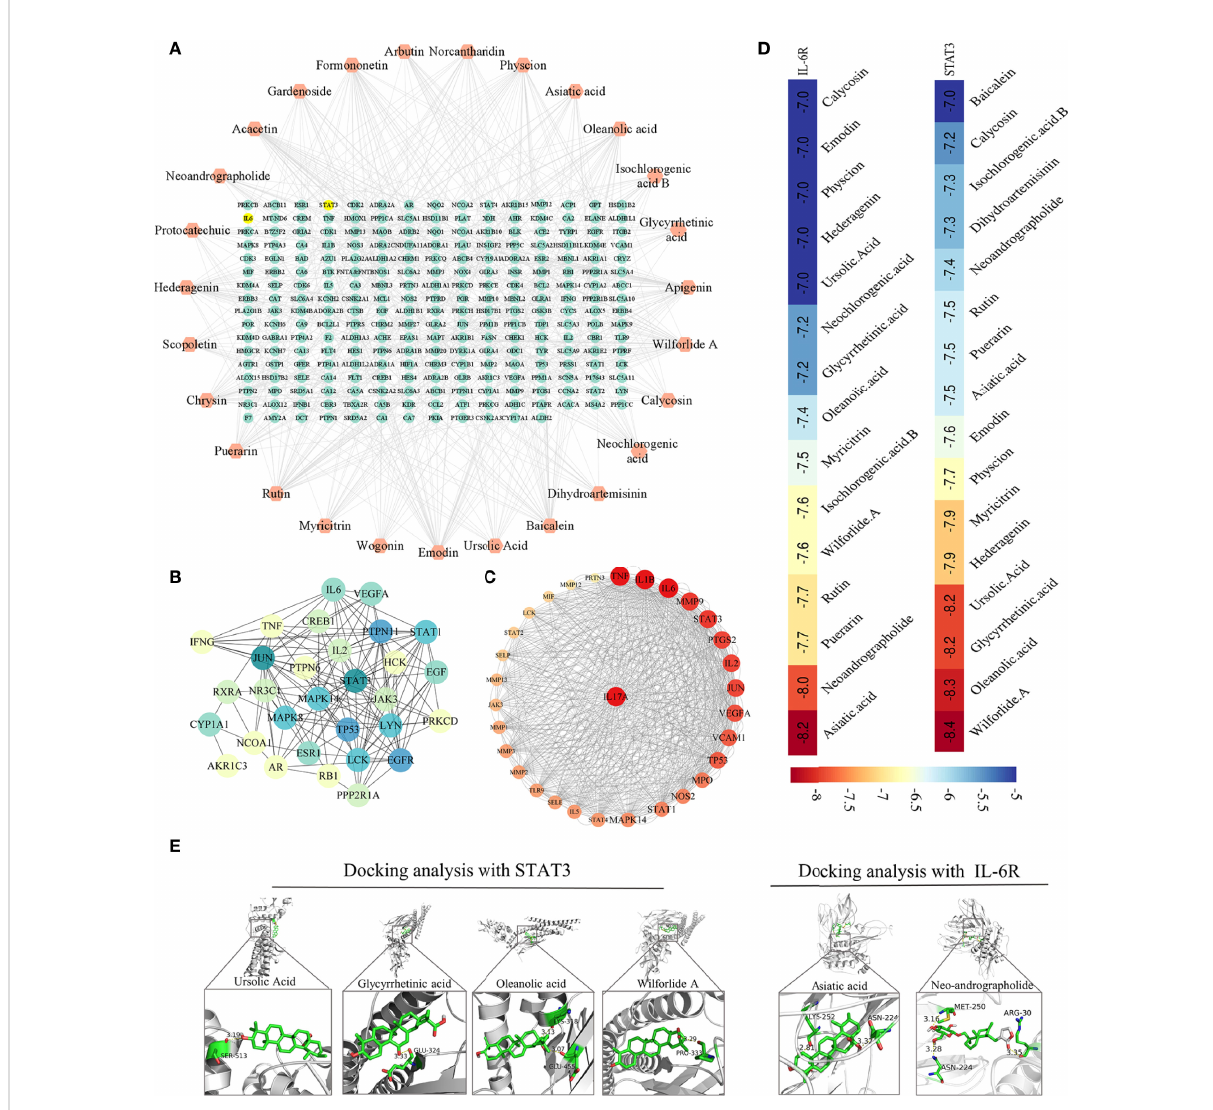
FIGURE 6 Network pharmacological analysis of active ingredients in HDW on the regulation of the IL-6/STAT3 pathway. (A) The 27 compounds-targets Network Diagram. (B) PPI of the top 30 targets fi ltered by degree algorithm. (C) PPI Map of the top 30 targets and IL-17, the targets are sorted in descending order in a circular layout based on the number of degrees. The size of the target re fl ects the number of degrees. (D) The compounds whose binding energy with STAT3 or IL-6R was lower than -7.0, with colors closer to red indicating a lower score. (E) The docking pose of STAT3 with glycyrrhetinic acid, oleanolic acid, ursolic acid, and wilforlide A (left); The docking pose of IL-6R with asiatic acid and neoandrographolide